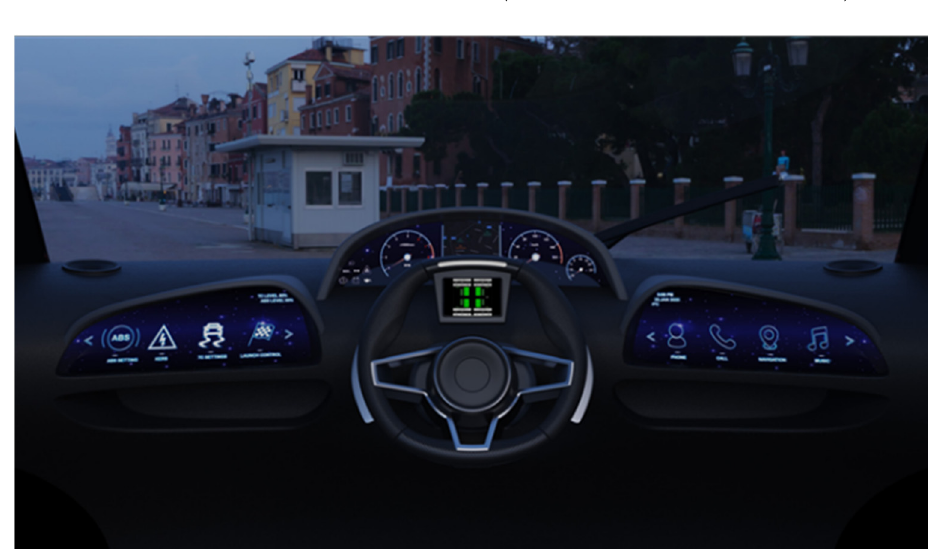
Figure 38. Dashboard and steering wheel rendering.